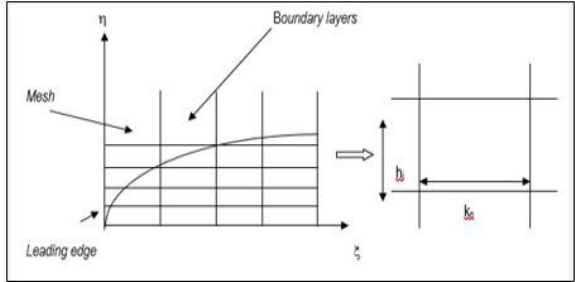
Fig. 2: Keller Box element and boundary layer mesh